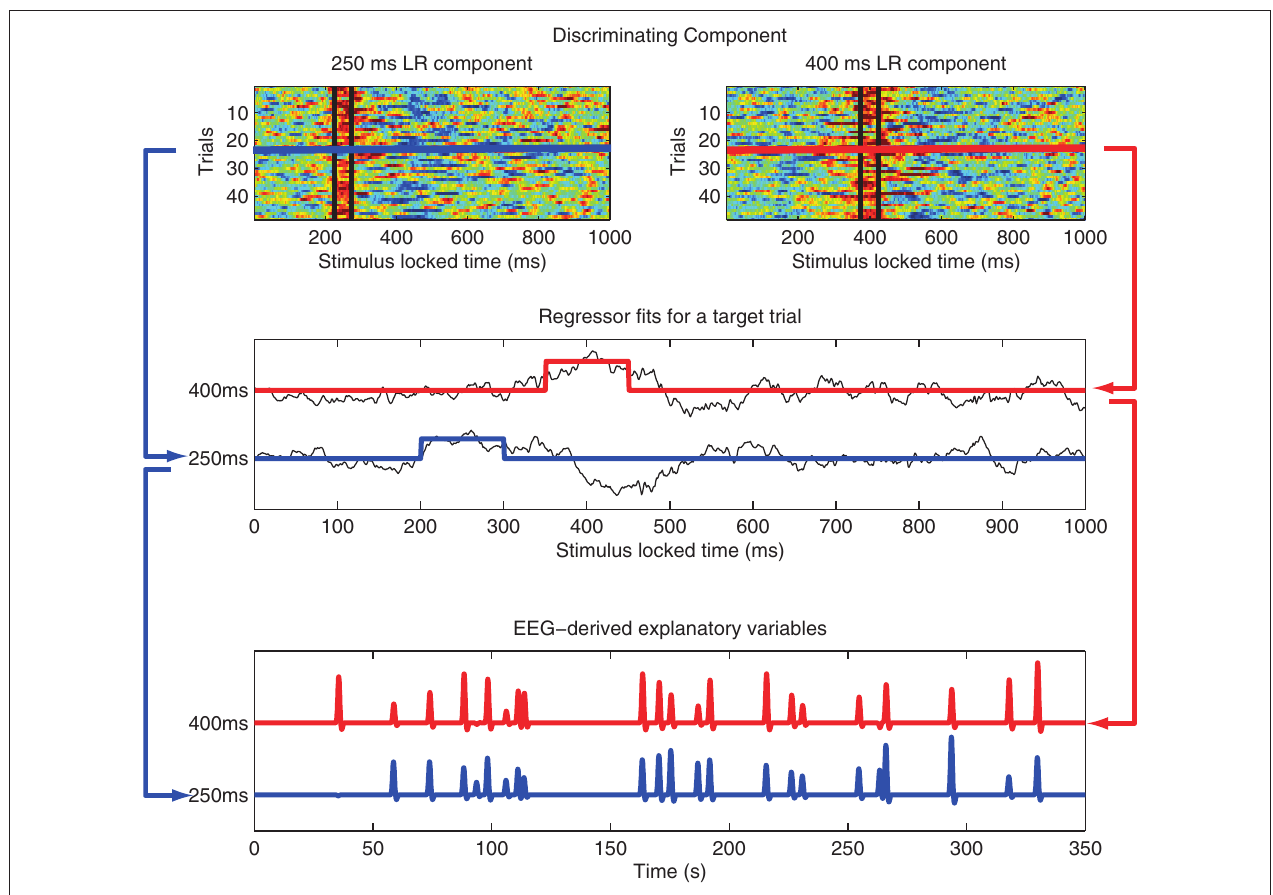
FIGuRE 2 | Method used to construct fMRI regressors from EEG component trial-to-trial variability. Top : y ‑values for all target trials of the single‑trial EEG discriminator for two stimulus‑locked windows. Data between black vertical bars indicates those y ‑values used in the analysis. In this example the window width is 50 ms, with one window centered at 200 ms and the other at 350 ms post stimulus‑onset. Hot to cold color scale indicates high likelihood to low likelihood for a target. Middle : y ‑value for a single target trial for each of the two components (black curves), showing the fMRI event model amplitude